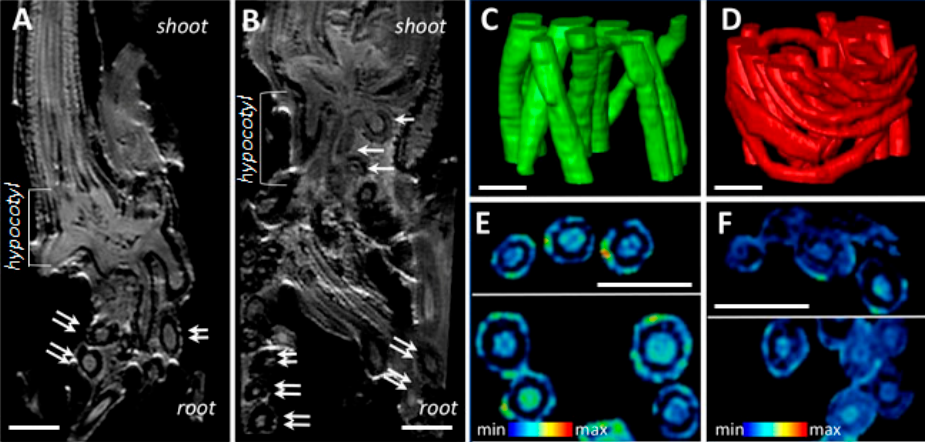
Figure 2. Comparative non-invasive magnetic resonance imaging (MRI) revealed structural changes in SST roots of H. marinum when compared to the control. ( A , B ) The representative virtual cross-sections show the internal structure of hypocotyl regions of plants growing under the control condition ( A ) and SST ( B ). Numerous root nodules in the hypocotyl region (white arrows) and root cross-sections (doubled arrows) are visible. ( C , D ) Fragments of the 3D models show spatial arrangement of the fibrous roots in control ( C , green) and SST ( D , red). ( E , F ) Relative differences in water distribution across the root tissues are visualized in virtual cross-sections of control ( E ) and SST ( F ) roots. MRI signal in ( E , F ) is at an identical scale and represented using a rainbow-based color scheme. High signal intensities in red (max) indicate high water saturation, while the blue regions (min) indicate lower water saturation. Scale bars = 1 mm.